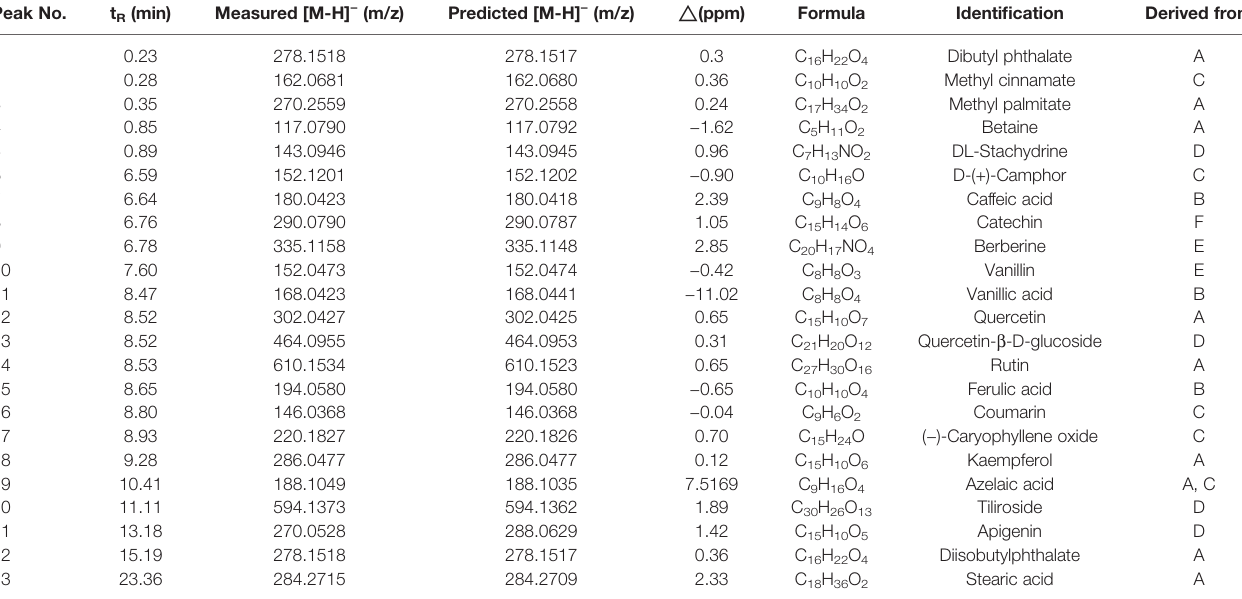
TABLE 1 | Components of Zi Shen Huo Luo Formula (ZSHLF) identi fi ed by UPLC-MS/MS analysis. Peak No. t R (min) Measured [M-H] − (m/z) Predicted [M-H] − (m/z) △ (ppm) Formula Identi fi cation Derived from 0.23